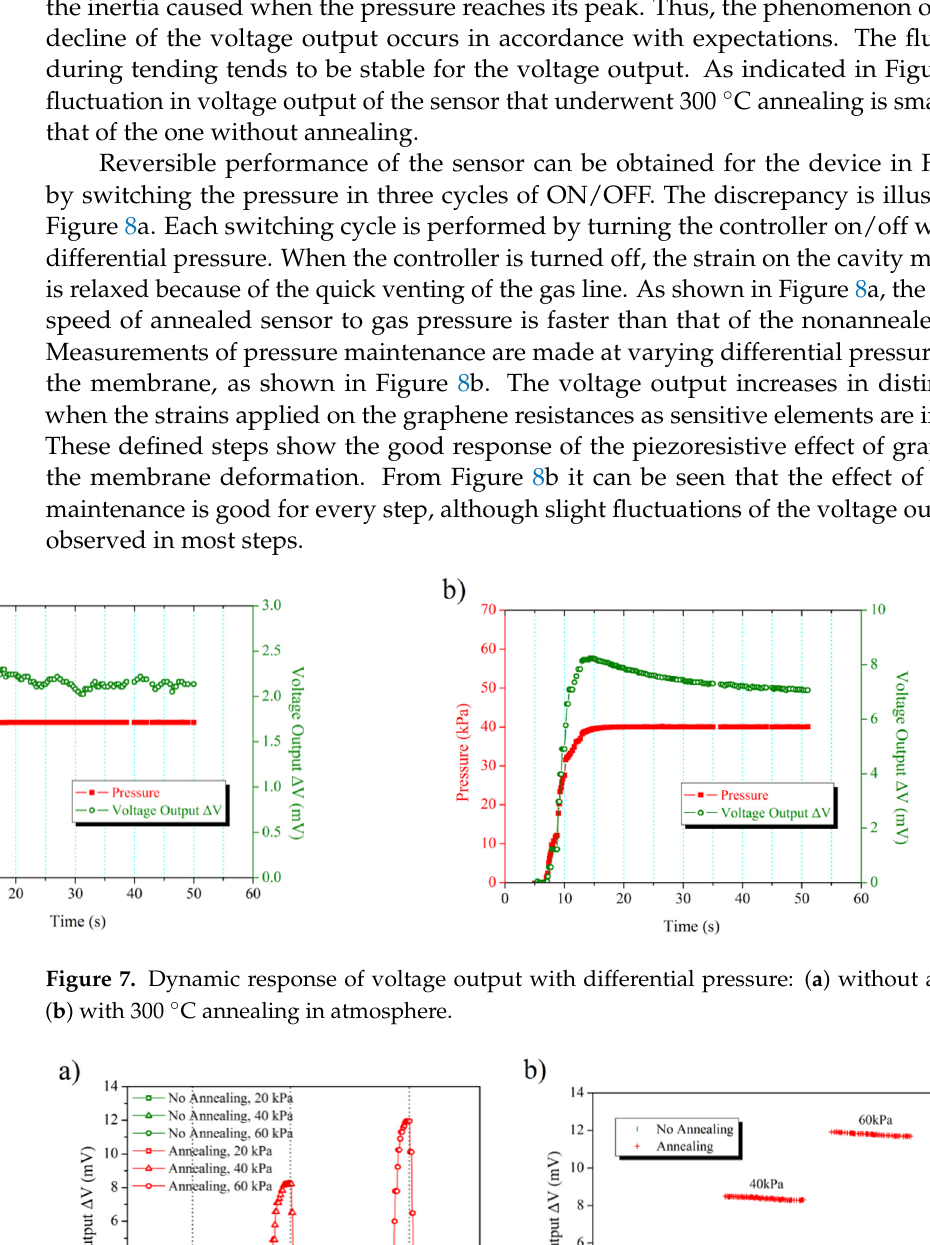
Table 2. Relevant data of the fitting curves in Figure 6.